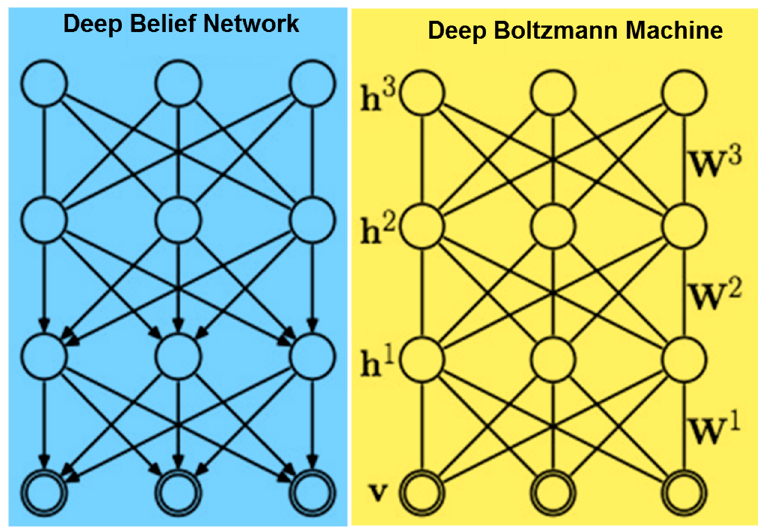
Figure 4. Mechanism of Deep Belief Network and Deep Boltzmann Machine.